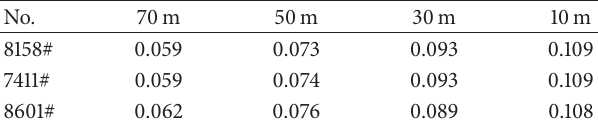
Figure 4: Comparison of wind speed between standard and actual air density. Table 8: Turbulence intensity at different